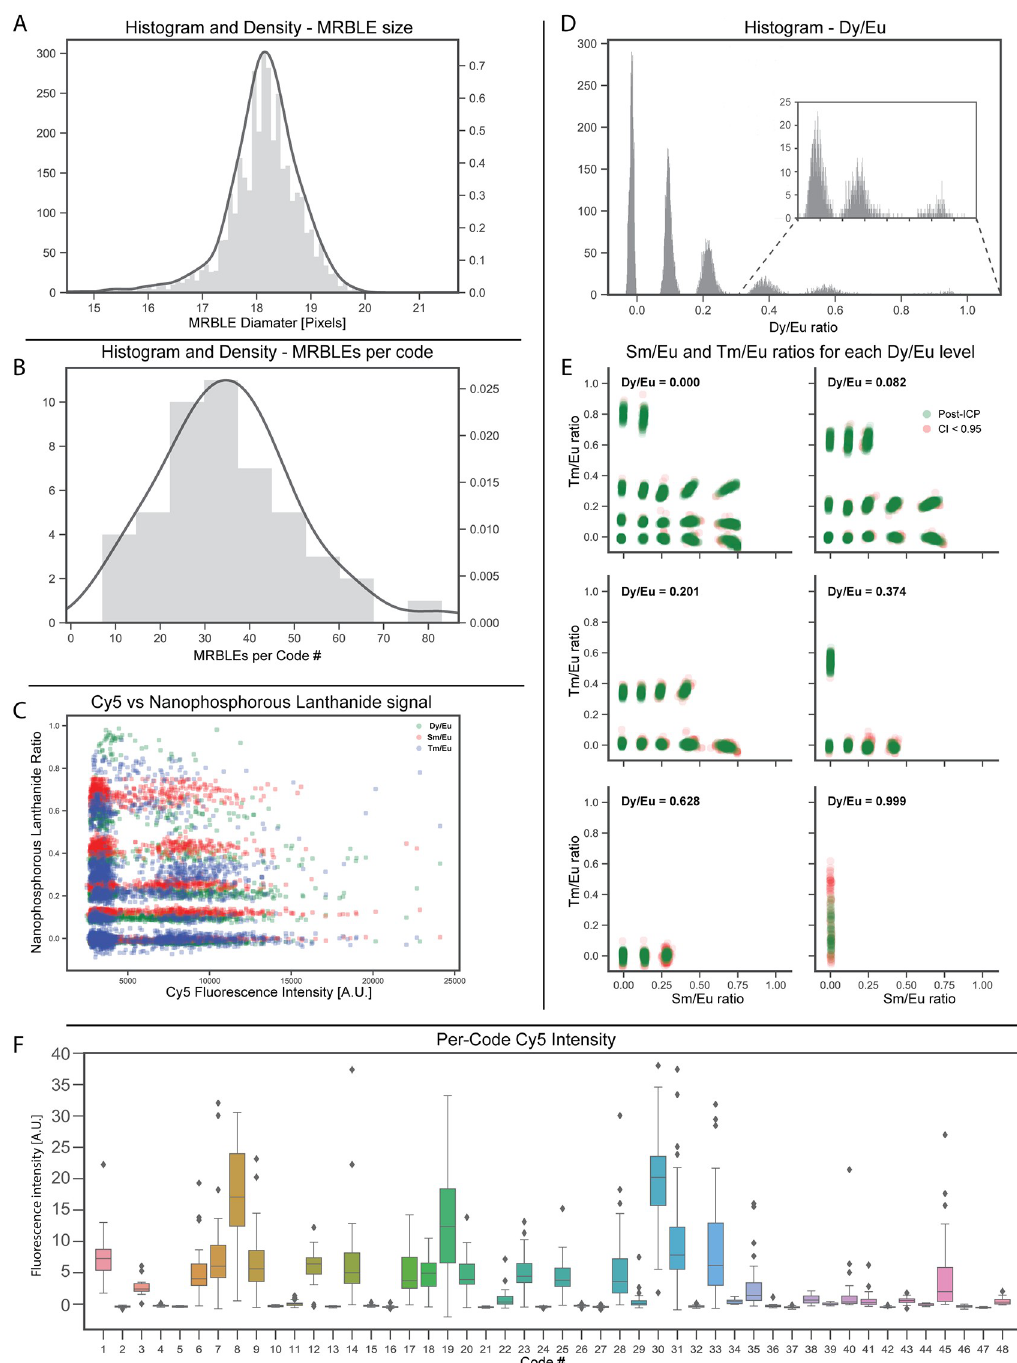
Fig 6. Quality control and final signal figures. A) MRBLE size distribution B) Per-code MRBLE distribution C) Fluorophore (Cy5) vs LNP signal, to demonstrate minimal correlation. D) Histogram of various Dy/Eu ratio levels E) The Sm/Eu and Tm/Eu ratio levels corresponding to the Dy/Eu ratios depicted above. F) Final per-code